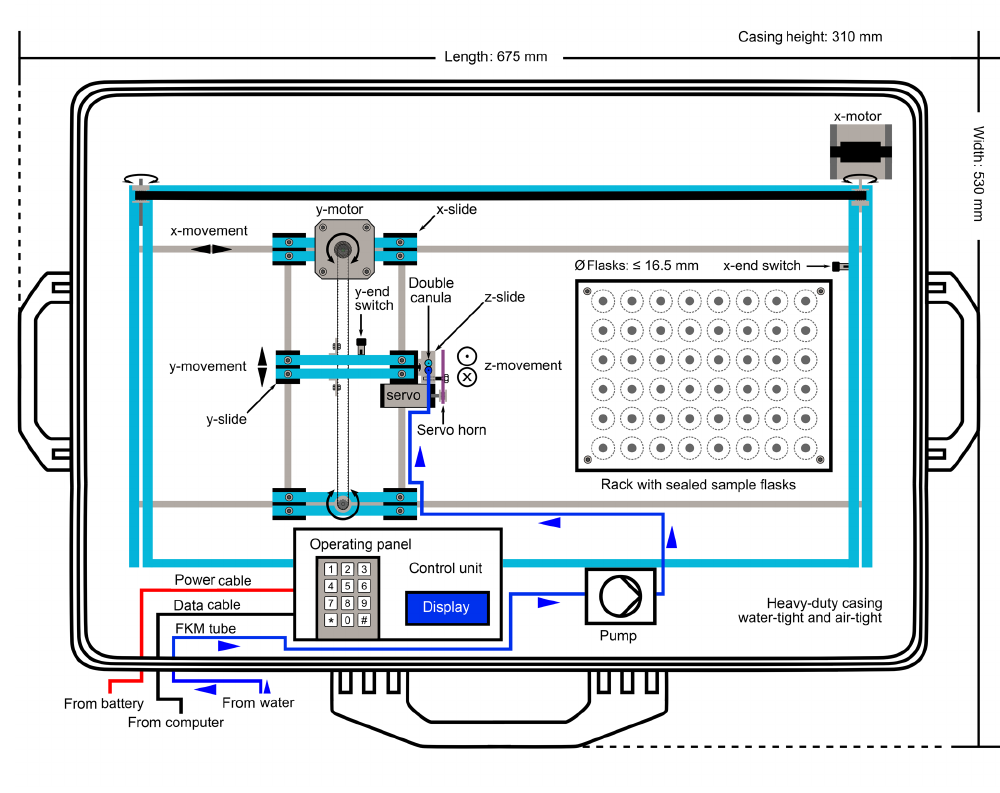
Figure 1. Hardware design of the GUARD autosampler (top view, schematical). Water samples are pumped directly into vials that are permanently gastight by rubber septa. The shown set-up comprises 48 sample vials, but the autosampler can be equipped with up to 160 sample vials at the given casing dimensions.